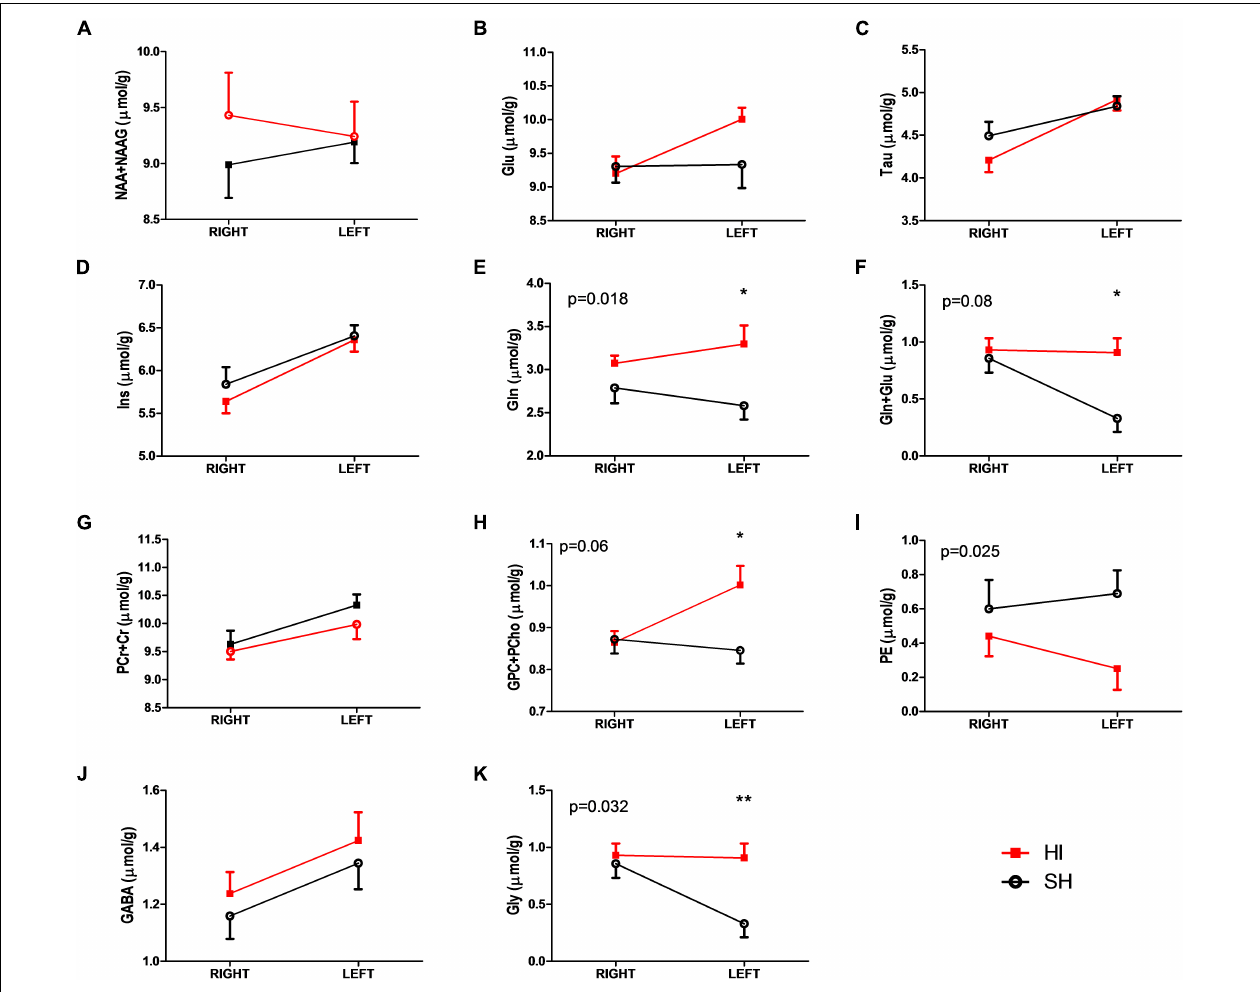
FIGURE 2 | Selected metabolic differences (A–K) between SH (open black circles) and HI (solid red squares) groups of adult rats following HI and SH at PND3. Two-way ANOVA analysis showed treatment differences with the corresponding p -values (E,J,K) . Total choline (GPC+PCho, H ) and total glutamine and glutamate (Gln+Glu, F ) showed different trends toward the significant level, i.e., p < 0.05. The further Bonferroni post-test revealed further differences, p -value < 0.05 was marked with “ ∗ ” and p -value < 0.01 was marked with “ ∗∗ .” Abbreviations were listed in the “Materials and